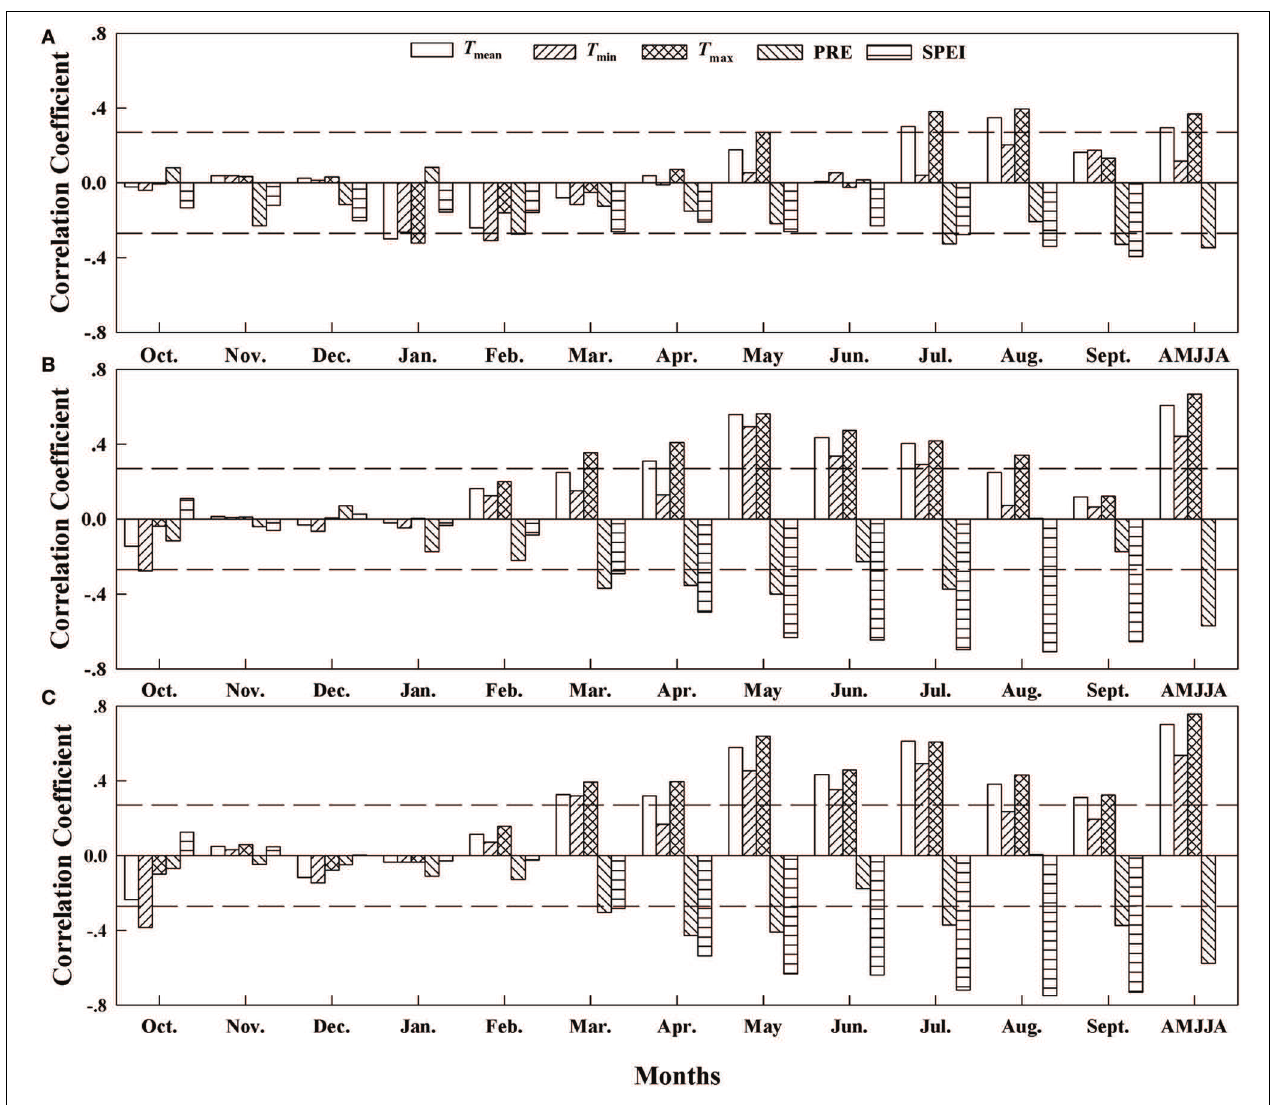
FIGURE 4 | Correlation coefficients (Pearson’s r ) between the δ 13 C residuals chronology and the climate variables from 1960 to 2010 at (A) Site A1 (2700m a.s.l.), (B) Site A2 (2400m a.s.l.), and (C) Site A3 (2200m a.s.l.). Horizontal dashed lines represent the 95% confidence